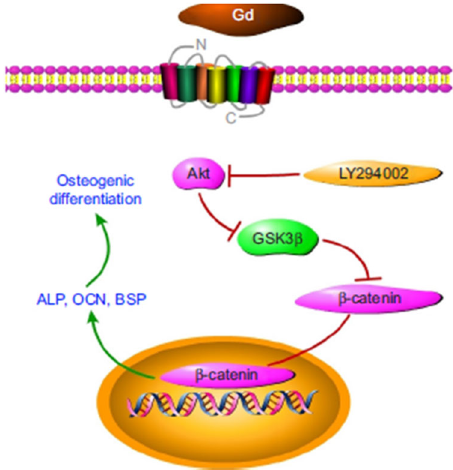
Fig. 3 Schematic diagram showing Gd dopant activation of the Akt/ GSK3 β signaling pathway [89]. Reproduced according to Creative Commons license (CC BY-NC